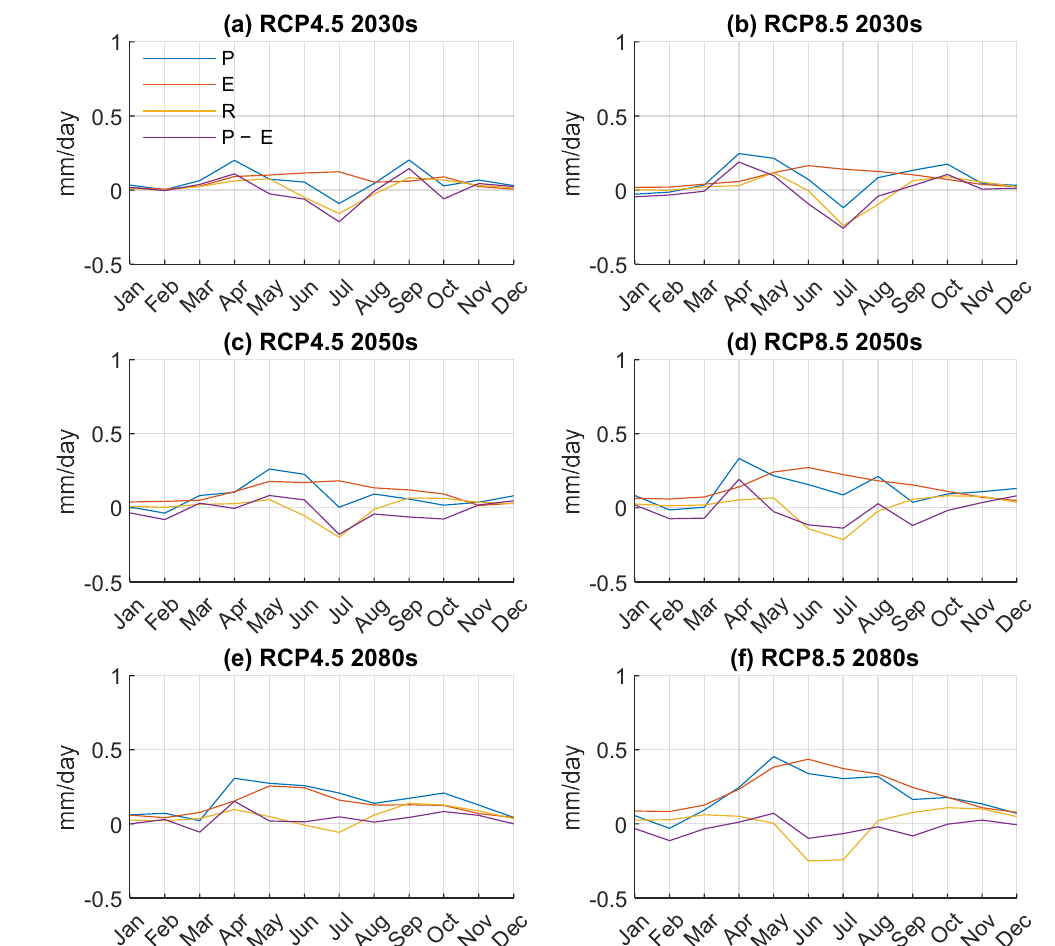
Figure 8. Projected changes in the annual cycles of precipitation, evapotranspiration, and runoff. Precipitation changes with respect to different warming levels under the two scenar- ios are shown in Table 4. The magnitudes of changes under the same warming level are similar under different scenarios. For example, with a domain average warming of 2 °C, the annual average precipitation is likely to increase by 0.12 and 0.13 mm/day under RCP4.5 and RCP8.5, respectively. This phenomenon is reasonable because, according to the Clausius–Clapeyron equation, the increase in the water holding capacity of the atmos- phere is the same given the same temperature increase. The change in precipitation is not necessarily the same since the actual amount of water vapor available can be different. At a warming level of 2 °C, spring and summer precipitation is also projected to increase by 0.15 and 0.17 mm/day under RCP4.5, and by 0.21 and 0.17 mm/day under RCP8.5. When domain average warming reaches 4 °C under RCP8.5, the annual, spring, and summer precipitation are projected to increase by 0.19, 0.24, and 0.27 mm/day, respectively.